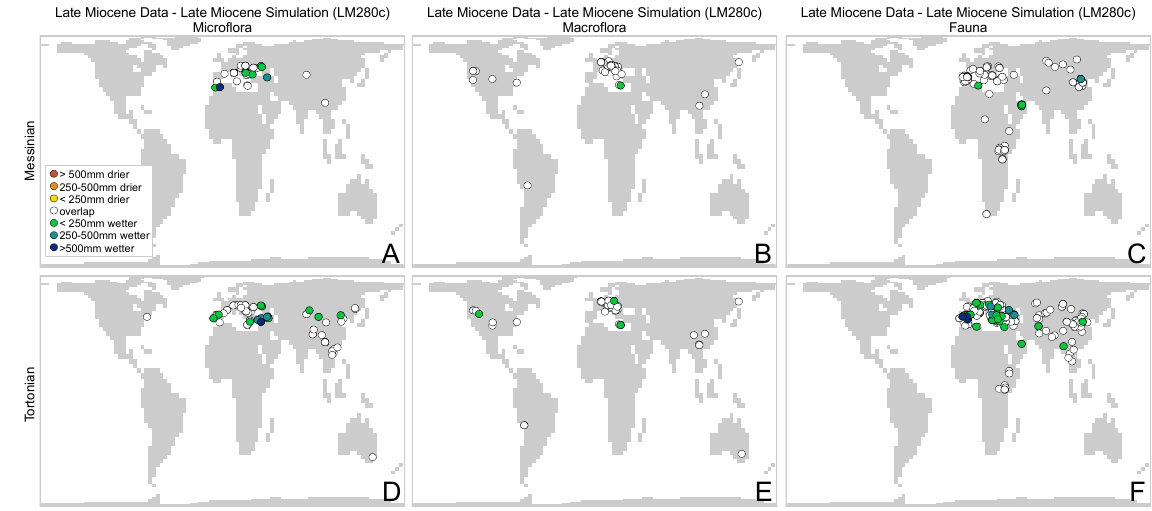
Fig. 12. Results from the model–data comparison for mean annual precipitation, late Miocene data–LM280c.